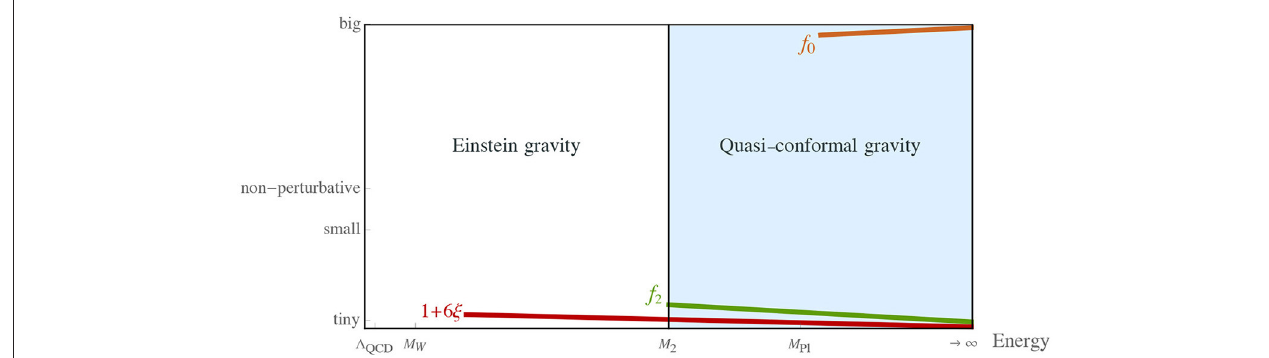
FIGURE 3 | Schematic behavior of the gravitational couplings as functions of the energy in a possible interesting scenario. At high energies the theory is approximately given by conformal gravity, with small corrections (which include the UV irrelevant Einstein-Hilbert and cosmological constant terms). Both 1 / f 0 and δ ab 6 ξ ab remain very small for the reasons given above. The coupling f 2 associated with the W 2 term is also chosen to be small both to maintain perturbativity and + thus calculability and to provide interesting and potentially observable effects at the inflationary scales. The running of f 2 is depicted only up to the mass of the f 2 ¯ M P / √ 2. A large coupling f 0 influences physics only at energies much above the Planck mass as its role compared to the corresponding degrees of freedom, M 2 = Einstein-Hilbert term is suppressed by E 2 / ( f 2 0 ¯ M 2 P ), where E is the typical energy of the process under study. Below M 2 the gravitational theory resembles Einstein gravity plus small corrections. The energy flows from the scale below which strong interactions are non-perturbative, 3 QCD , up to infinite energy (passing through the mass of the W-boson M W , the ghost mass M 2 and the Planck mass M Pl